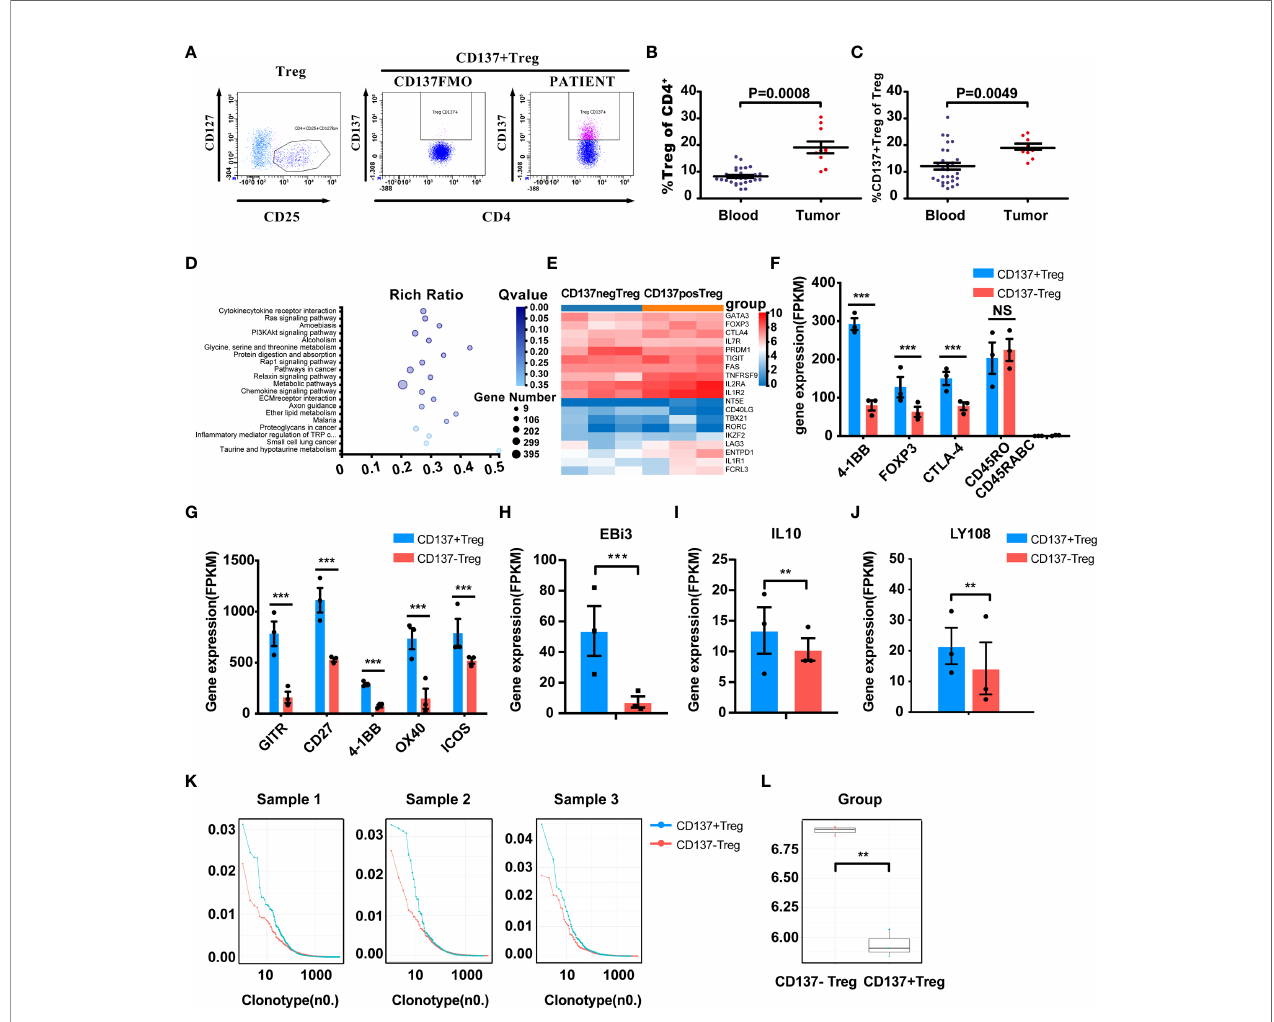
FIGURE 4 | Enrichment and characterization of CD137+ Tregs in the tumor microenvironment. (A) Gated CD137+ Tregs derived from human cancer tissues via FACS; middle panel, CD137+ Tregs FMO control. (B, C) Treg and CD137+ Treg in fi ltration in tumors (n=10, unpaired samples) compared with the blood of lung cancer patients. P values are shown. (D) PI3K-AKT pathway-related molecules were differentially expressed in the CD137+ and CD137- Treg populations according to KEGG pathway analysis. (E) Comparative heatmap of the expression of Treg-associated markers, including transcription factors, in CD137+ Tregs (orange) and CD137- Tregs (blue). (F) The expression of eTreg-related markers in CD137+ Tregs and CD137- Tregs. (G) The expression of activated T cell markers in CD137+ Tregs and CD137- Tregs. (H – J) Differential expression of EBi3, IL-10 and LY108 in CD137+ Tregs and CD137- Tregs. ***Q value < 0.001, **Q value < 0.01. (K) The TCR clone frequency in CD137+ Tregs and CD137- Tregs in three individual samples was compared after TCB sequencing. (L) , TCR clone diversity in the two groups, **P< 0.01. The error bars represent the SEMs.